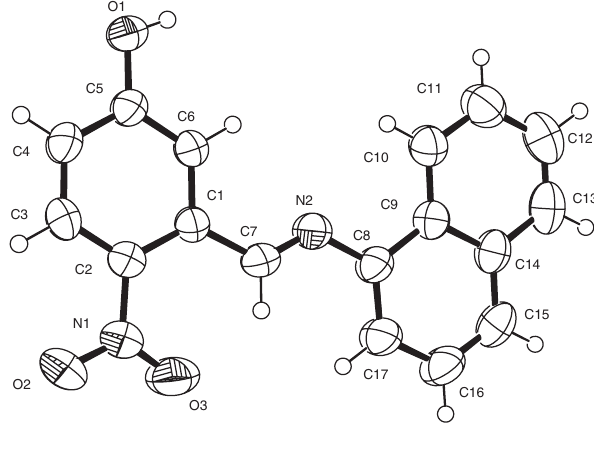
Table 1: Data collection and